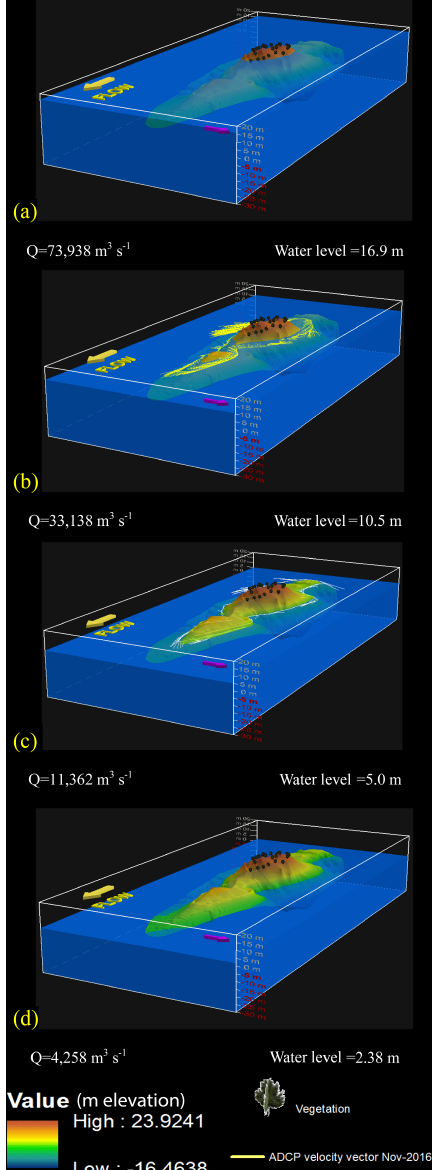
Figure 6. Evolution of a mid-channel bar during falling waters. The yellow (b) and white (c) lines that surround the island represent the flow velocity vectors for the periods of high and low waters,